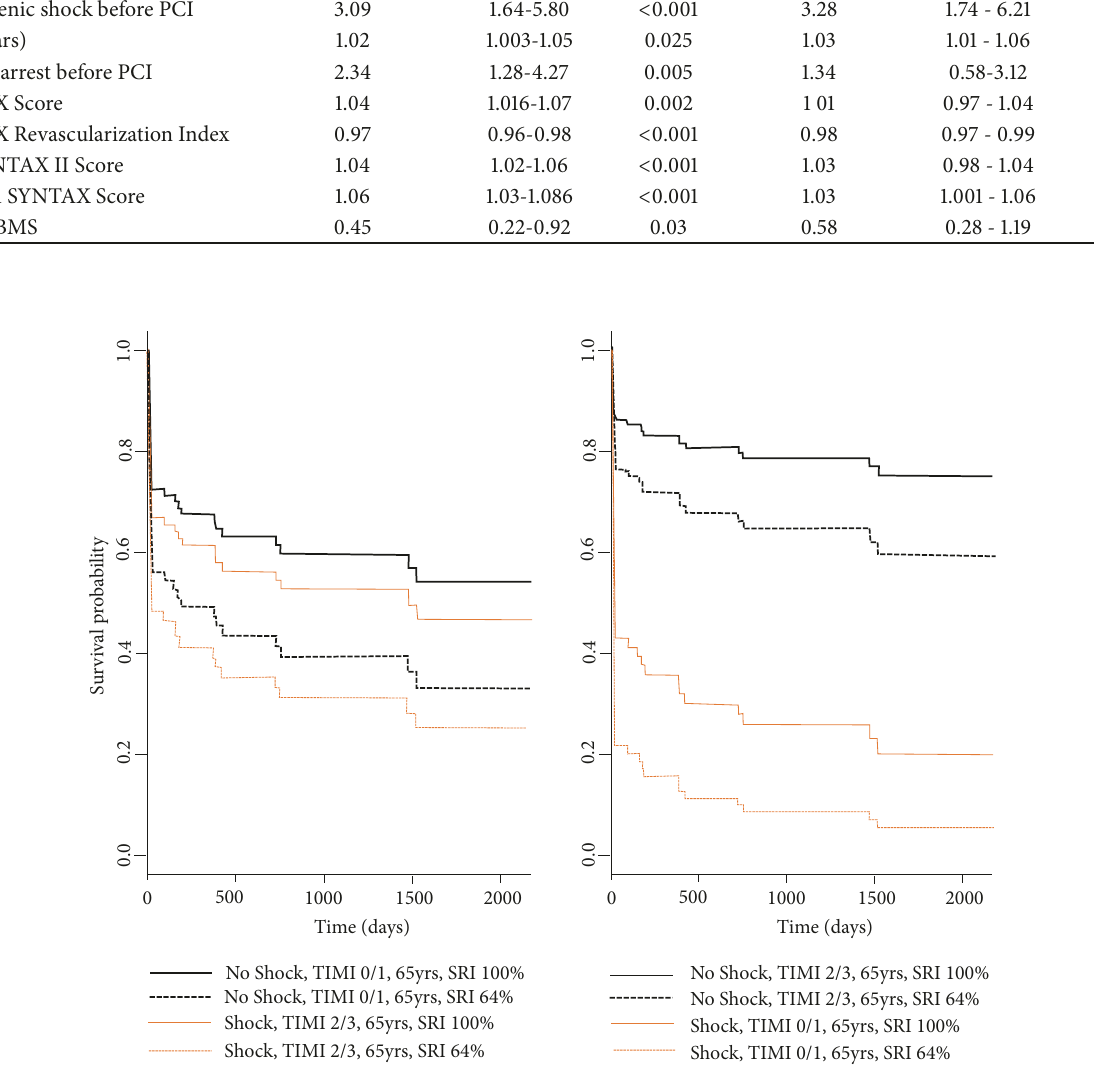
Figure 3: Predicted survival curves: the survival curves are predicted with a multivariate Cox model for the first (64%) and the third (100%) quartiles of SYNTAX Revascularization Index in different scenarios: with and without shock, TIMI 0/1 or 2/3, and adjusted for the subjects mean age (65 years). TIMI =Thrombolysis in Myocardial Infarction; yrs =